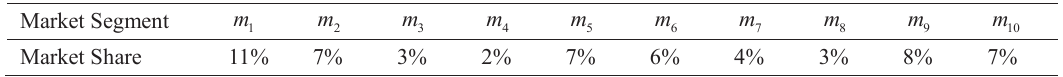
Table 4. Segments and their market shares